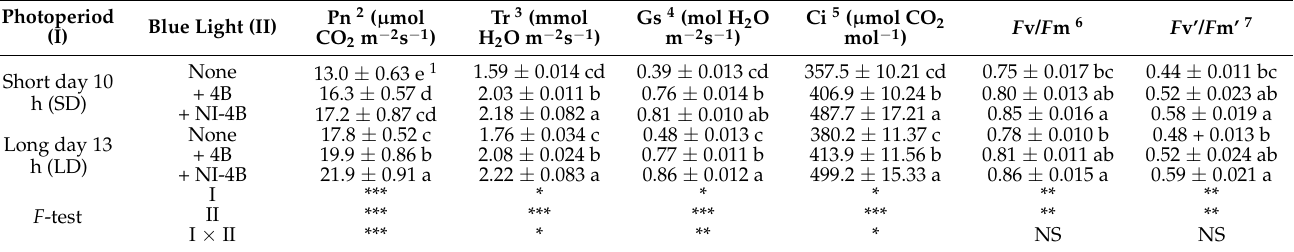
1 Mean separation within columns by Duncan’s multiple range test at p ≤ 0.05 and the mean ± standard error ( n = 6). 2 Net photosynthetic rate ( P n). 3 Transpiration rate ( T r). 4 Stomatal conductance ( G s). 5 Intercellular CO